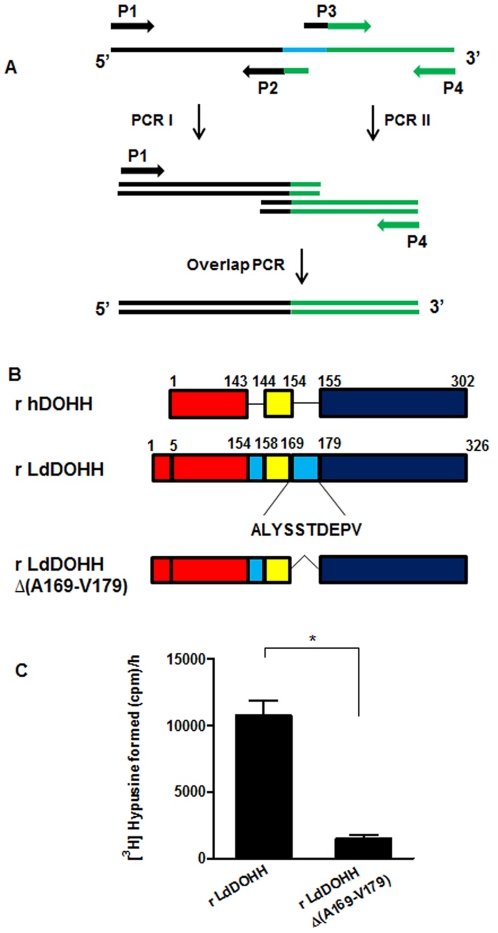
Effect of deletion mutation on the activity of L. donovani DOHH.(A) Scheme representing overlap extension PCR used for deletion of the ten-amino-acid-long insertion from LdDOHH. The regions shown in black and green are the regions upstream and downstream of the region to be deleted (shown in cyan blue). (B) Alignment showing human DOHH, LdDOHH and LdDOHH ▵(A169-V179). The regions that are similar between hDOHH and LdDOHH and align with each other are shown in red, yellow and blue color. Cyan blue color shows the insertions present in LdDOHH. (C) Comparison of the radioactivity in aminopropionaldehyde obtained as a result of [3H]hypusine formation after the DOHH assay with the recombinant LdDOHH enzyme or the mutant LdDOHH ▵(A169-V179) enzyme. The results presented are the mean ± SD of triplicate samples. *, p<0.05.